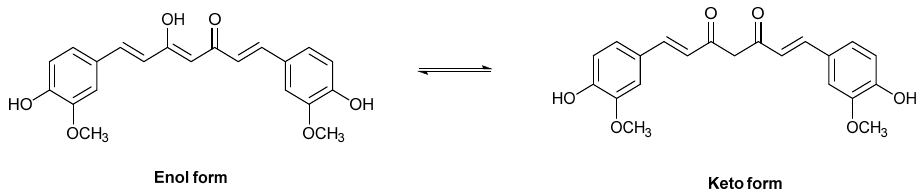
Figure 1. Structure of curcumin (enol and keto forms).